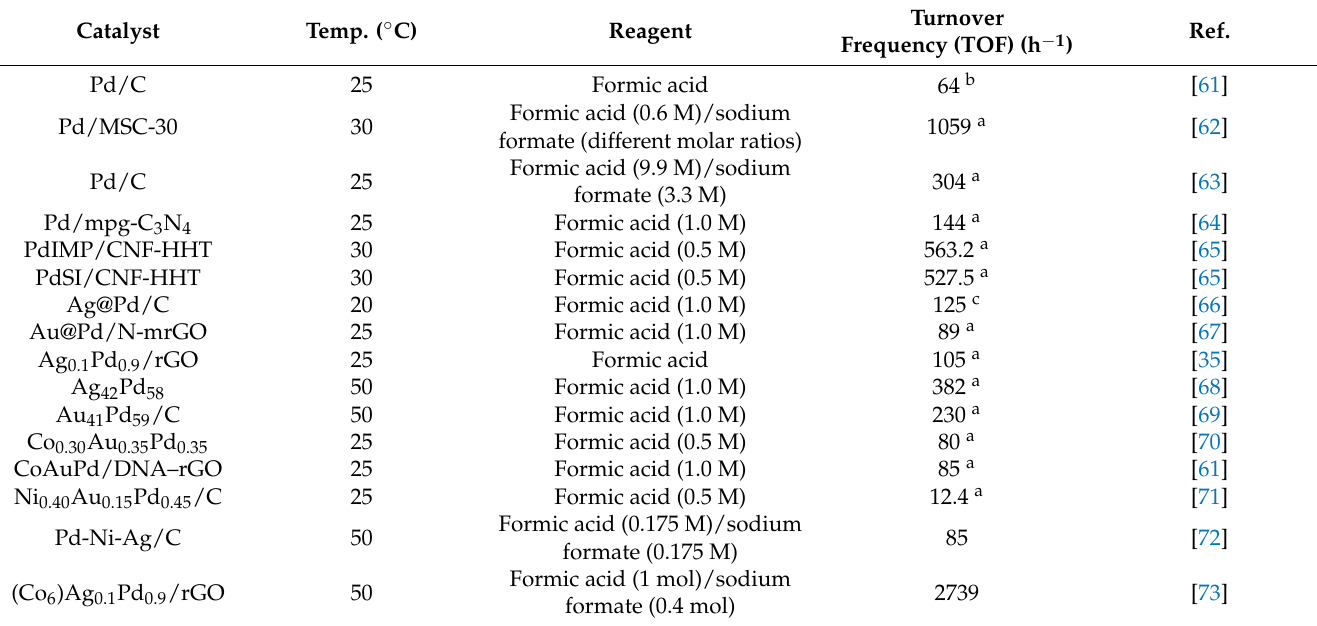
Table 1. Nanoheterogeneous catalysts to decompose aqueous formic acid at ambient temperature (20–50 ◦